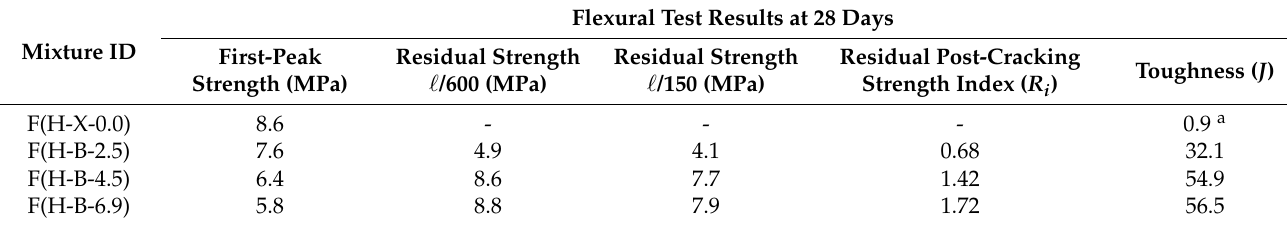
Table 8. Mechanical properties of the full depth specimens at 28 days.